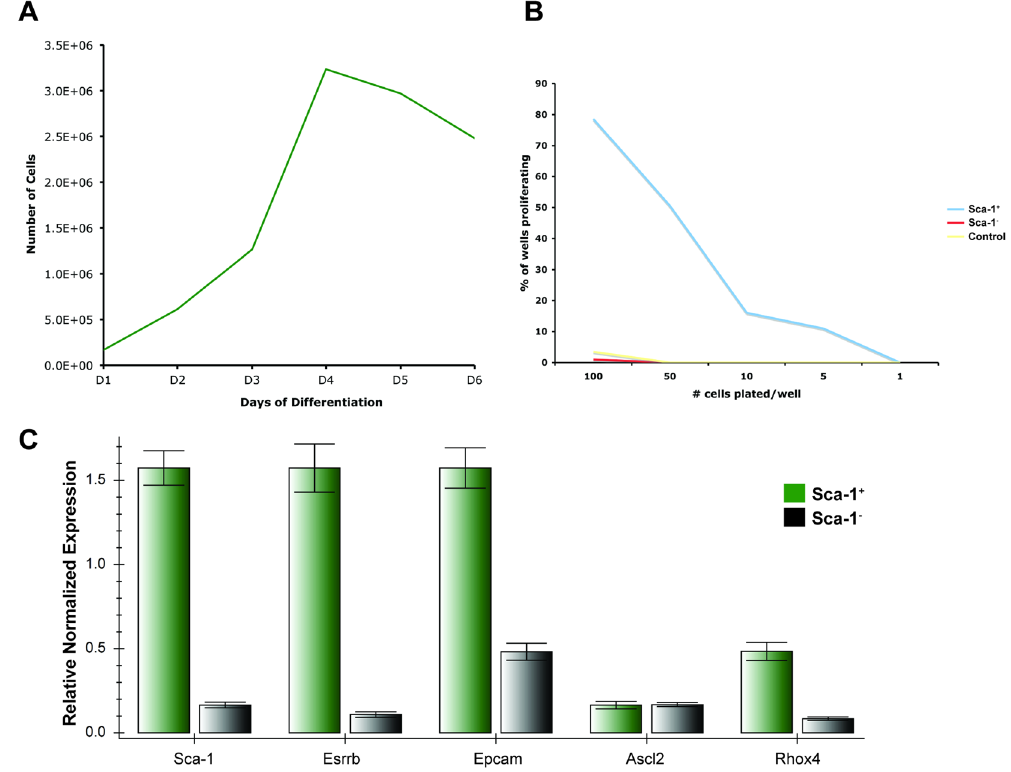
Figure 2. Upon removal of FGF4, mouse TS cell cultures were initially proliferative but increased in number only until day 4 of differentiation ( A ). Sca-1 + trophoblast cells isolated from non-proliferating, differentiated TS cultures and plated at decreasing densities in conditions to support TS proliferation formed colonies however Sca-1 − and non-sorted, differentiated TS cells did not ( B ). When these cells were compared to the Sca-1 − subpopulation of trophoblast cells by qRT-PCR, Sca-1 + positive cells displayed higher expression of Sca-1 and the trophoblast stem and progenitor markers, Esrrb and Epcam, Rhox4 , respectively, while Ascl2 was not different ( C